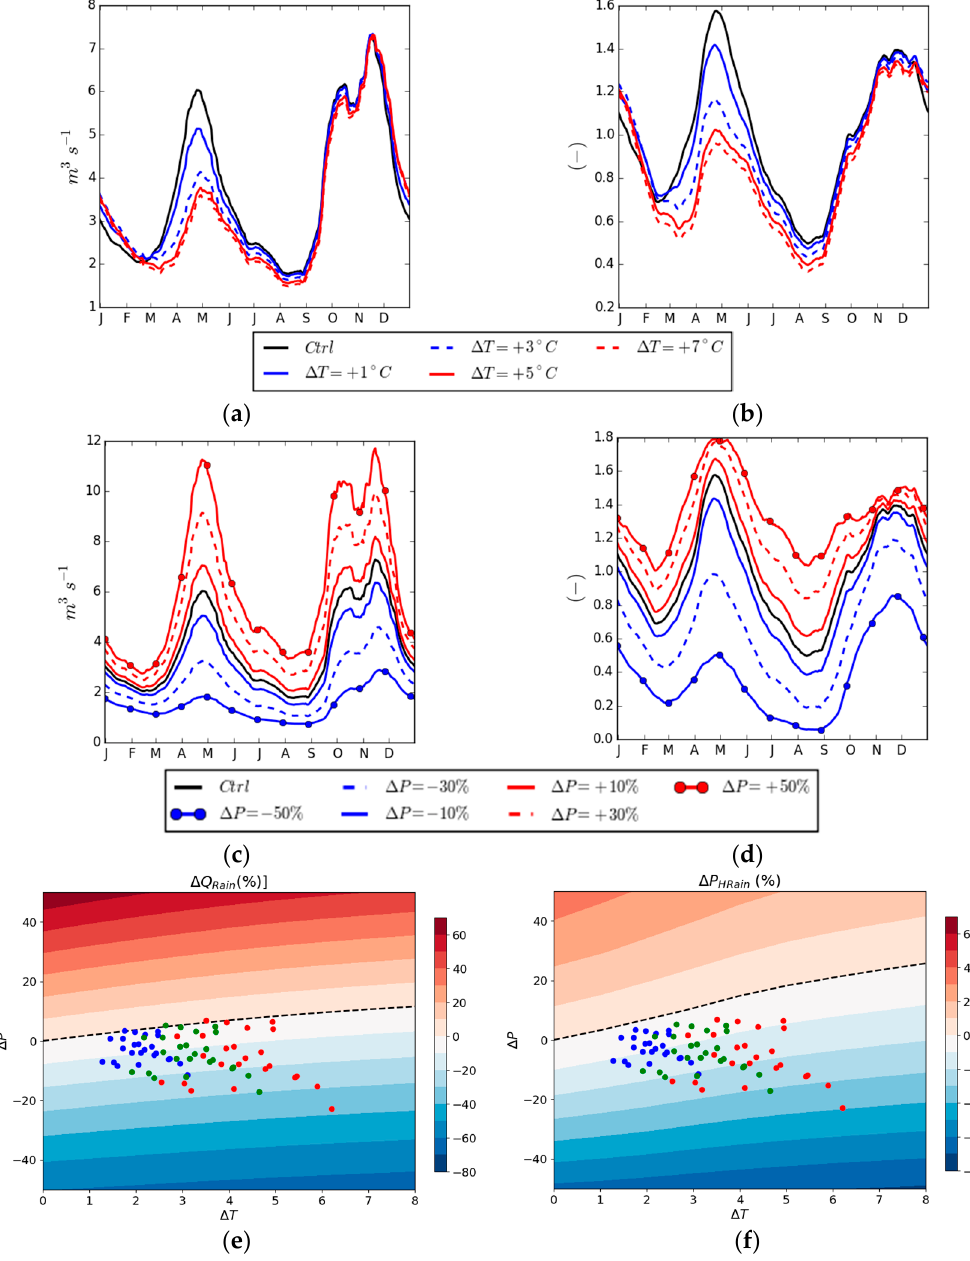
Figure 6. Average cycle of discharges ( a , c ) and RoR power generation ( b , d ) obtained for different temperature changes ∆ T ( a , b ) or precipitation changes ∆ P ( c , d ) over the Posina catchment. The cycles are smoothed over moving window of 30 days. RoR cycles were normalized regarding the generation obtained for the control climate. The climate response functions ( e , f ) respectively represent the changes (%) in average annual of discharge and RoR power generation. Dots show change factors for temperature and precipitation expected from CMIP5 experiments (see Figure 3 for details). The dashed black curve shows the ‘no change’ edge.